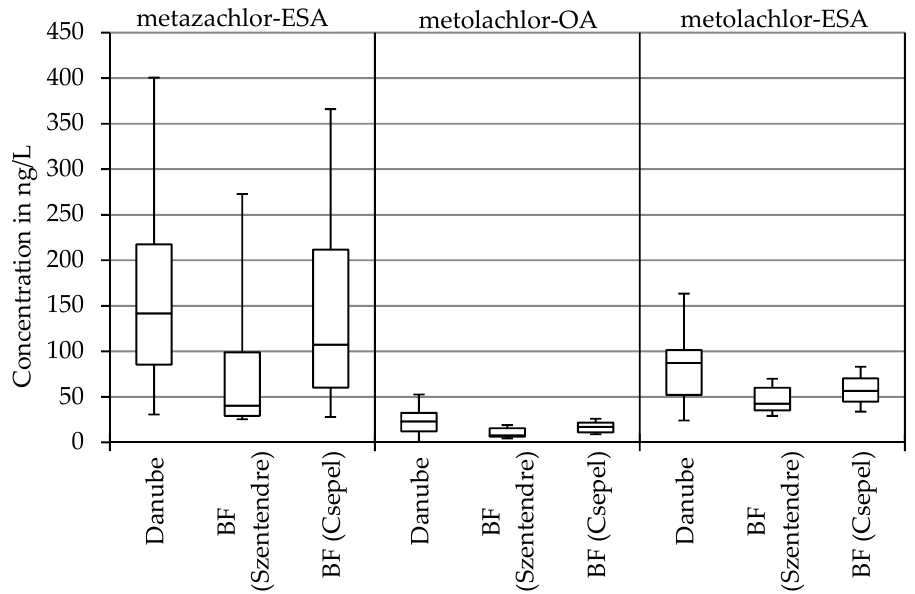
Figure 5. Boxplots representing concentrations of herbicides, pesticides, and transformation products in the Danube River water and bank filtrate.